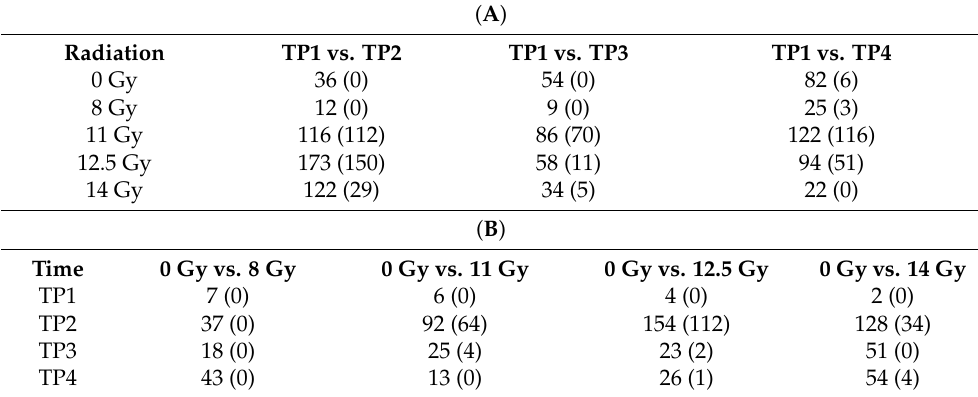
Table 2. Differential abundance analysis. The table represents the number of metabolites that showed significant changes for pairs of groups for radiation dose ( A ) and time point ( B ) where a fold change of 2 and p value < 0.05 were used as the cutoff. The numbers in parentheses represent the number of differentially abundant metabolites with a fold change > 2 and BH-adjusted p value < 0.05. ( A ) Radiation TP1 vs. TP2 TP1 vs.